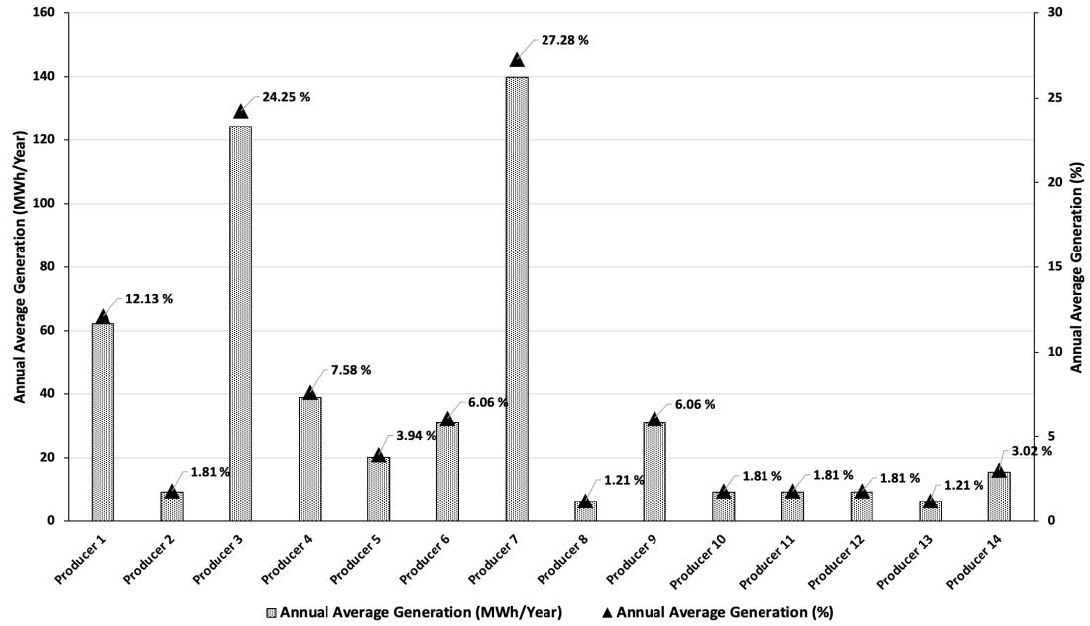
Figure 7. Estimated generation chart of electro-producer centers in the north of Portugal REC.